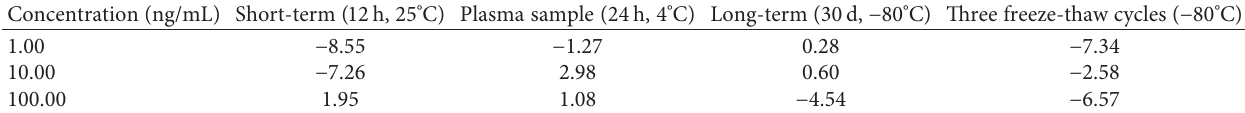
Table 4: Stability of TMEA under different storage condition (RSD%, n � 6).